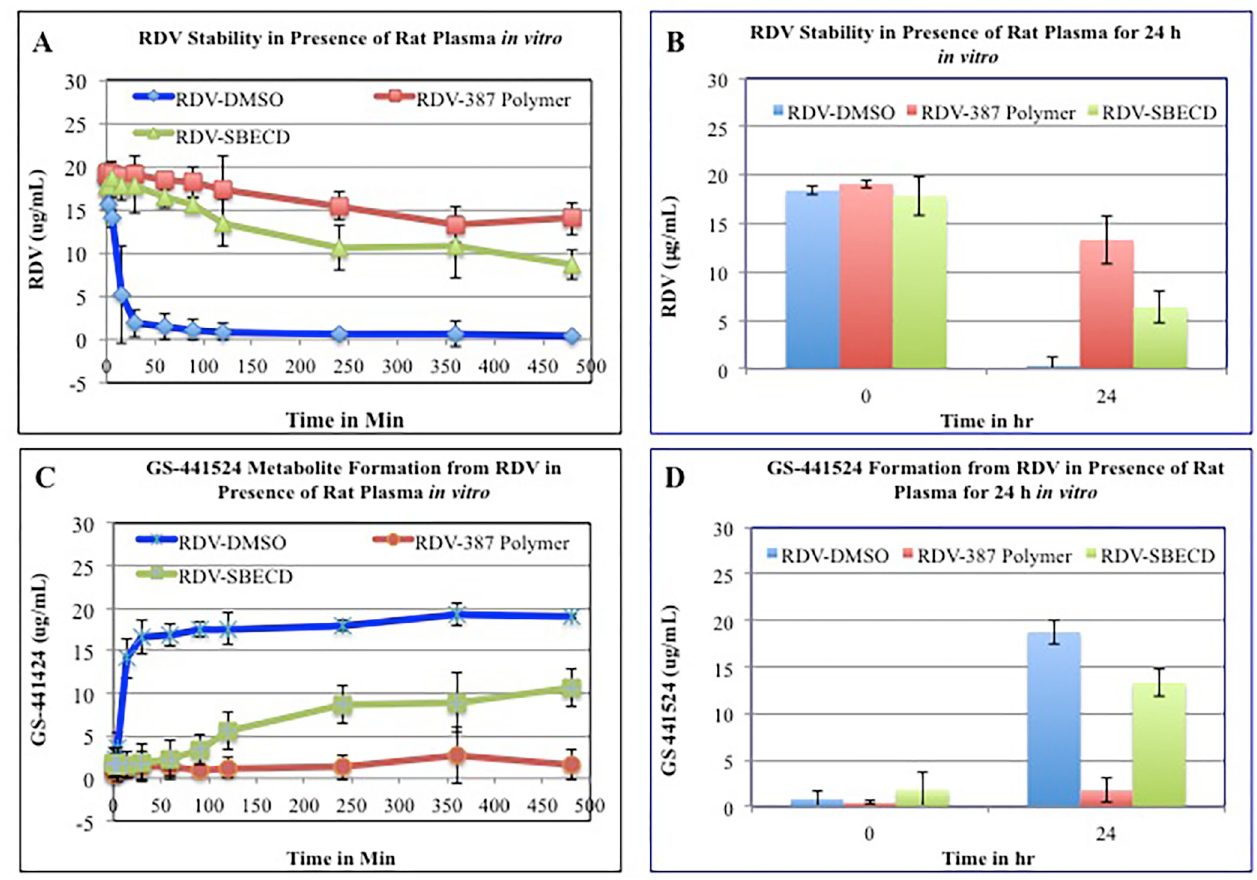
Fig 3. Protection efficiency of NV-CoV-2 encapsulation of RDV (NV-CoV-2-R) from plasma mediated degradation in vitro .